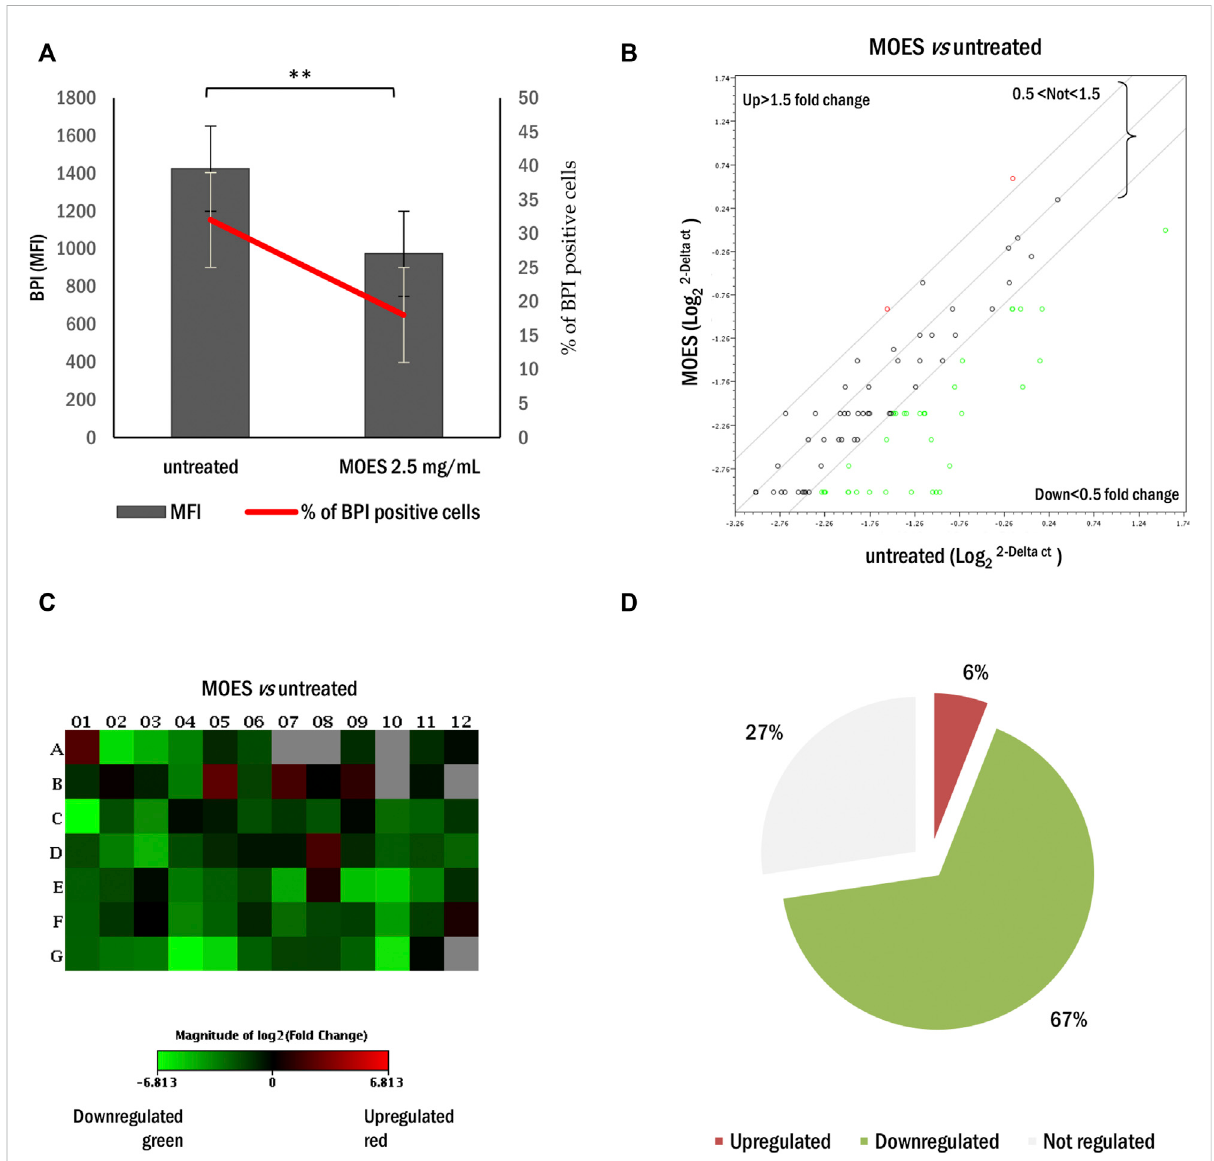
FIGURE 2 EffectofMOESonlipidmetabolismintheHepG2cells. (A) MFI(black column)andpercentage (redline)ofBPIpositive HepG2cellstreatedwith MOES. All results derived from at least three independent biological experiments. The histogram reports the mean ± SD (** p < 0.01). Unpaired Student ’ st-testwasused. (B) Thescatter plotarraypro fi leofgenesinvolved inlipid metabolism inHepG2cells. ElaborationbyRT 2 Pro fi lerPCRArray DataAnalysissoftware.Values > 1.50or < 0.5wereconsideredsigni fi cantlyupregulated(reddots)anddownregulated(greendots),respectively. (C) TherelativeHeatMapshowstheexpressionofupregulated(red)anddownregulated(green)genesinHepG2treatedwithMOES. (D) Thenumber of genes and their percentage values, regulated by MOES, represented as Pie